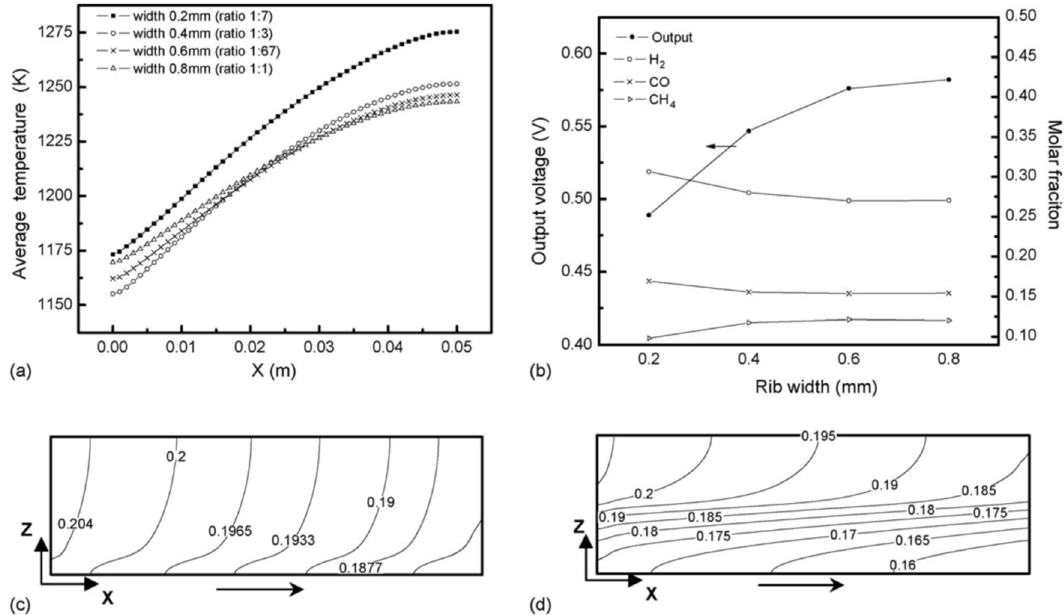
Figure 11. Effects of rib width on SOFC performance: ( a ) average top interconnector temperature, ( b ) comparison of performance, ( c ) oxygen at the cathode/electrolyte interface with the thinnest rib (ratio 1:7), ( d ) oxygen at cathode/electrolyte interface with the thickest rib (ratio 1:1) (figure reprinted from Ji et al. [104] Copyright (2006), with permission from Else- vier).